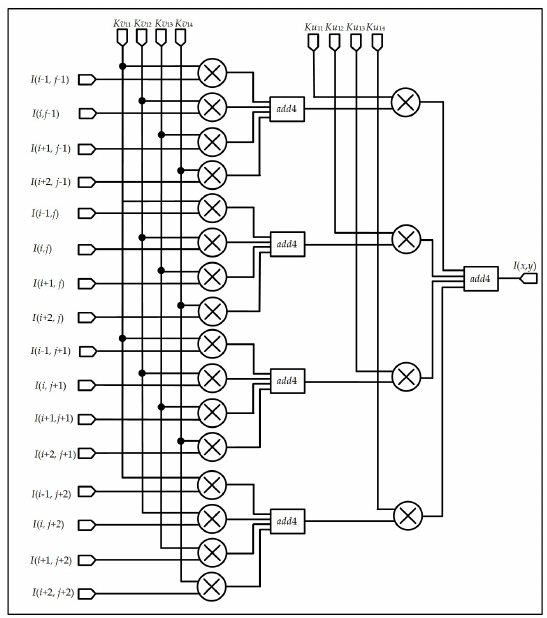
Figure 10. The architecture of PP-CCI.